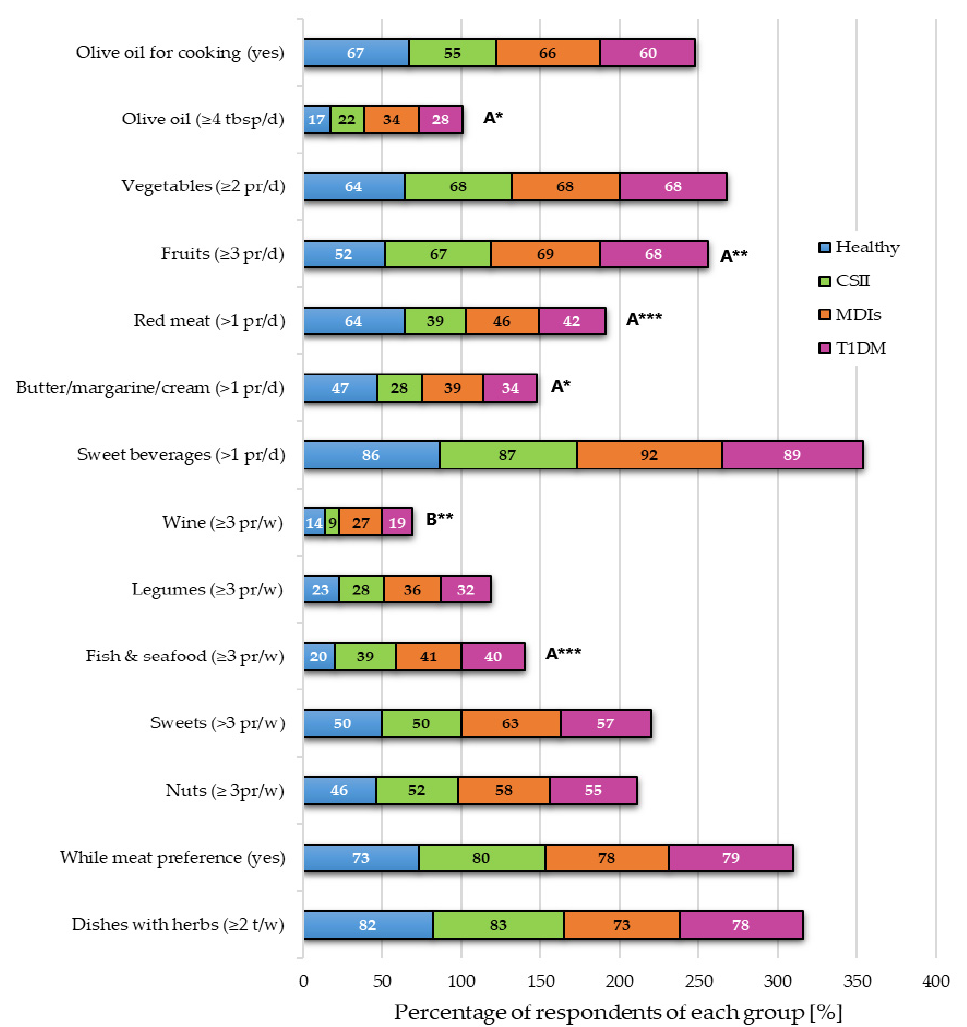
Figure 3. Percentage of respondents consuming certain portion sizes of product groups characteristic of the Mediterranean diet. Values are expressed as percentage of respondents (%). Abbreviations: continuous subcutaneous insulin infusion (CSII), multiple daily injections (MDIs), Mediterranean Diet Adherence Screener (MEDAS), Mediterranean Diet (MD), number of respondents (n), daily (d), weekly (w), portion (pr), tablespoon (tbsp), times (t), type 1 diabetes mellitus (T1DM). Statistically significant dependence between variables: A T1DM vs. Healthy, B CSII vs. MDIs (the Chi-square test), * p < 0.05, ** p < 0.01, *** p < 0.001. The size of portion: vegetables200 g, sweet or beverages 200 mL, meat and fish 100–150 g, legumes 150 g, wine 125 mL, fruits 100 g, nuts 10 g, butter/margarine/cream 12